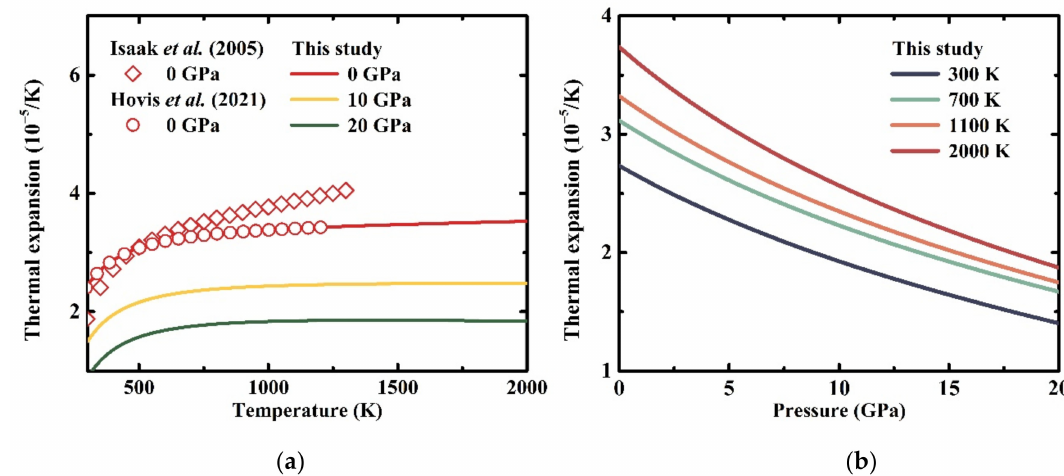
Figure 4. Temperature ( a ) and pressure ( b ) dependences of the thermal expansion of diopside. Solid lines refer to our calculated results. The diamonds and circles correspond to the results from Isaak et al. (2006) [33] and Hovis et al. (2021) [29],